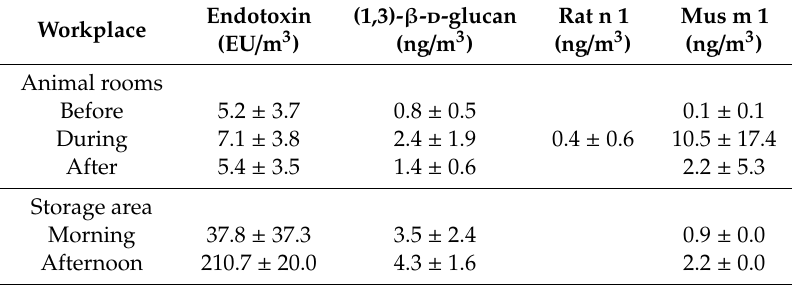
Table 4. Concentrations (mean value and standard deviation) of inhalable endotoxin, (1,3)- β - d -glucan, Rat n 1 and Mus m 1 by working